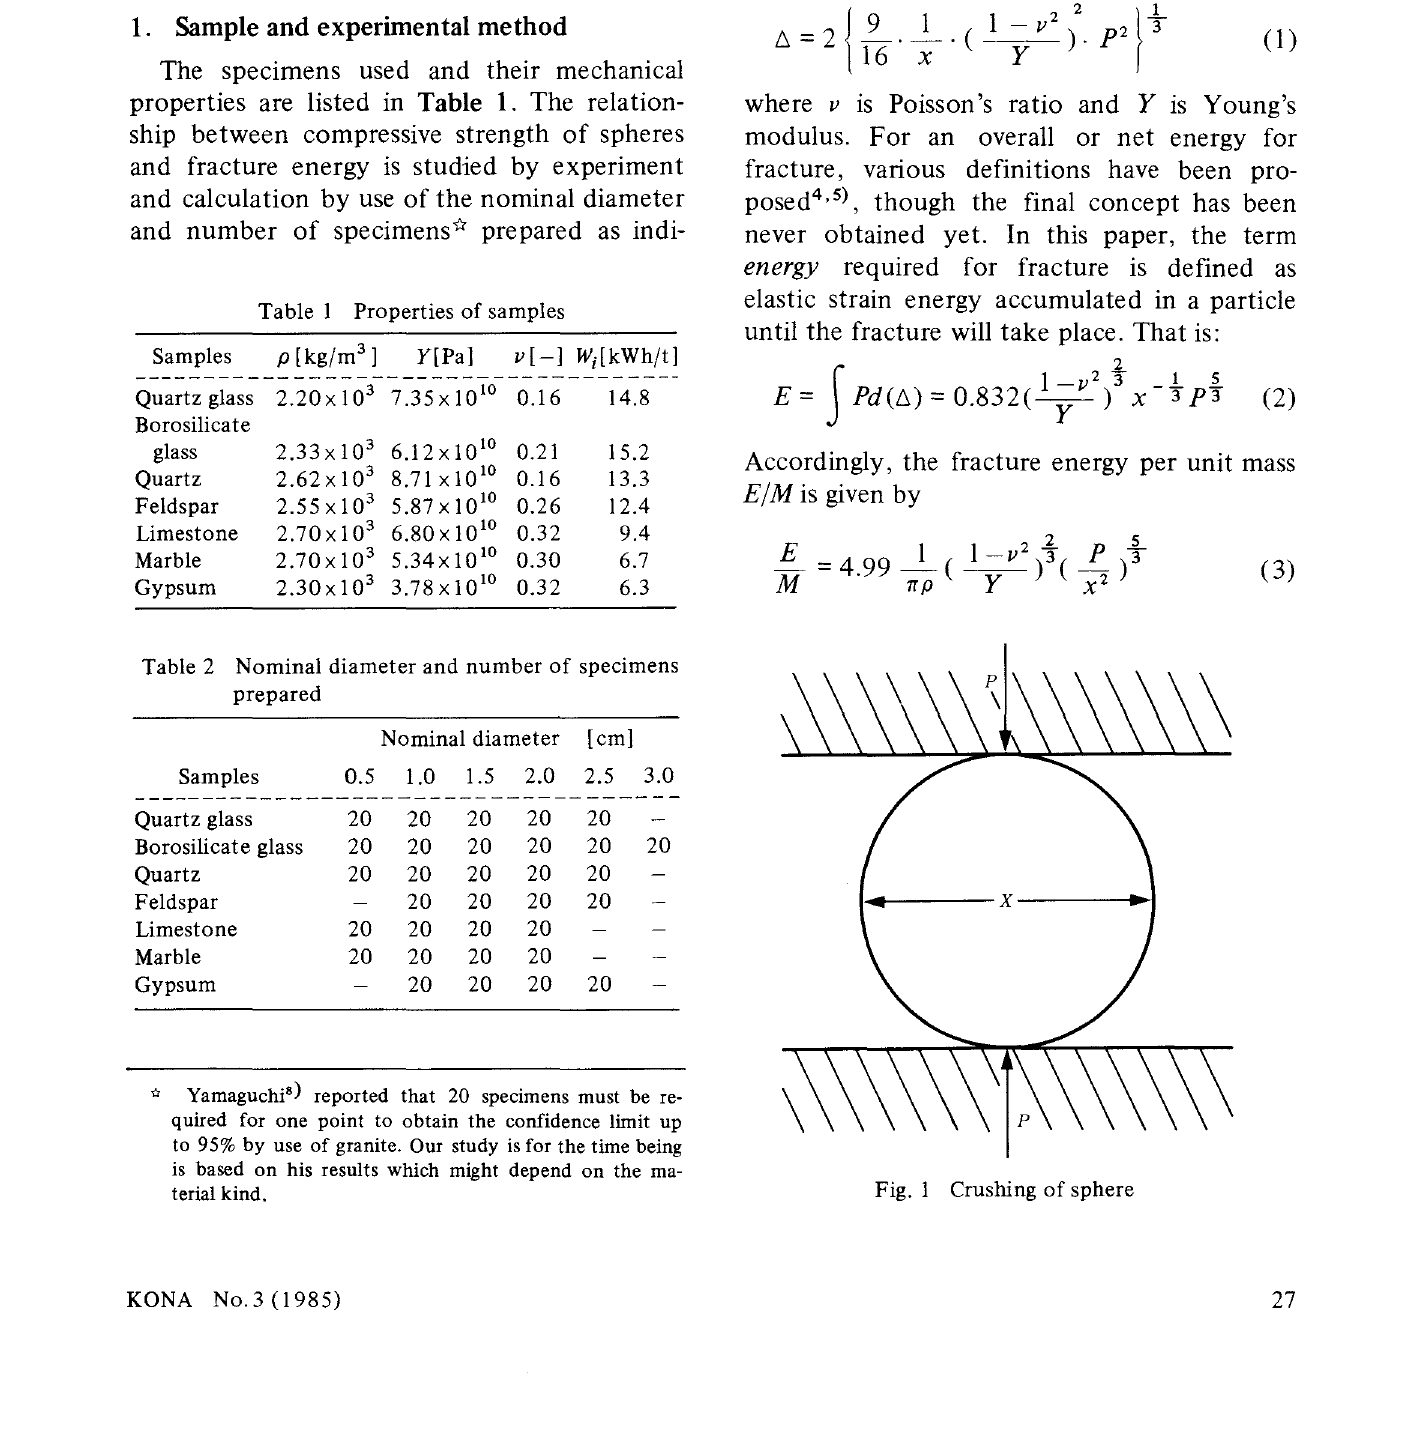
Fig. 1 Crushing of